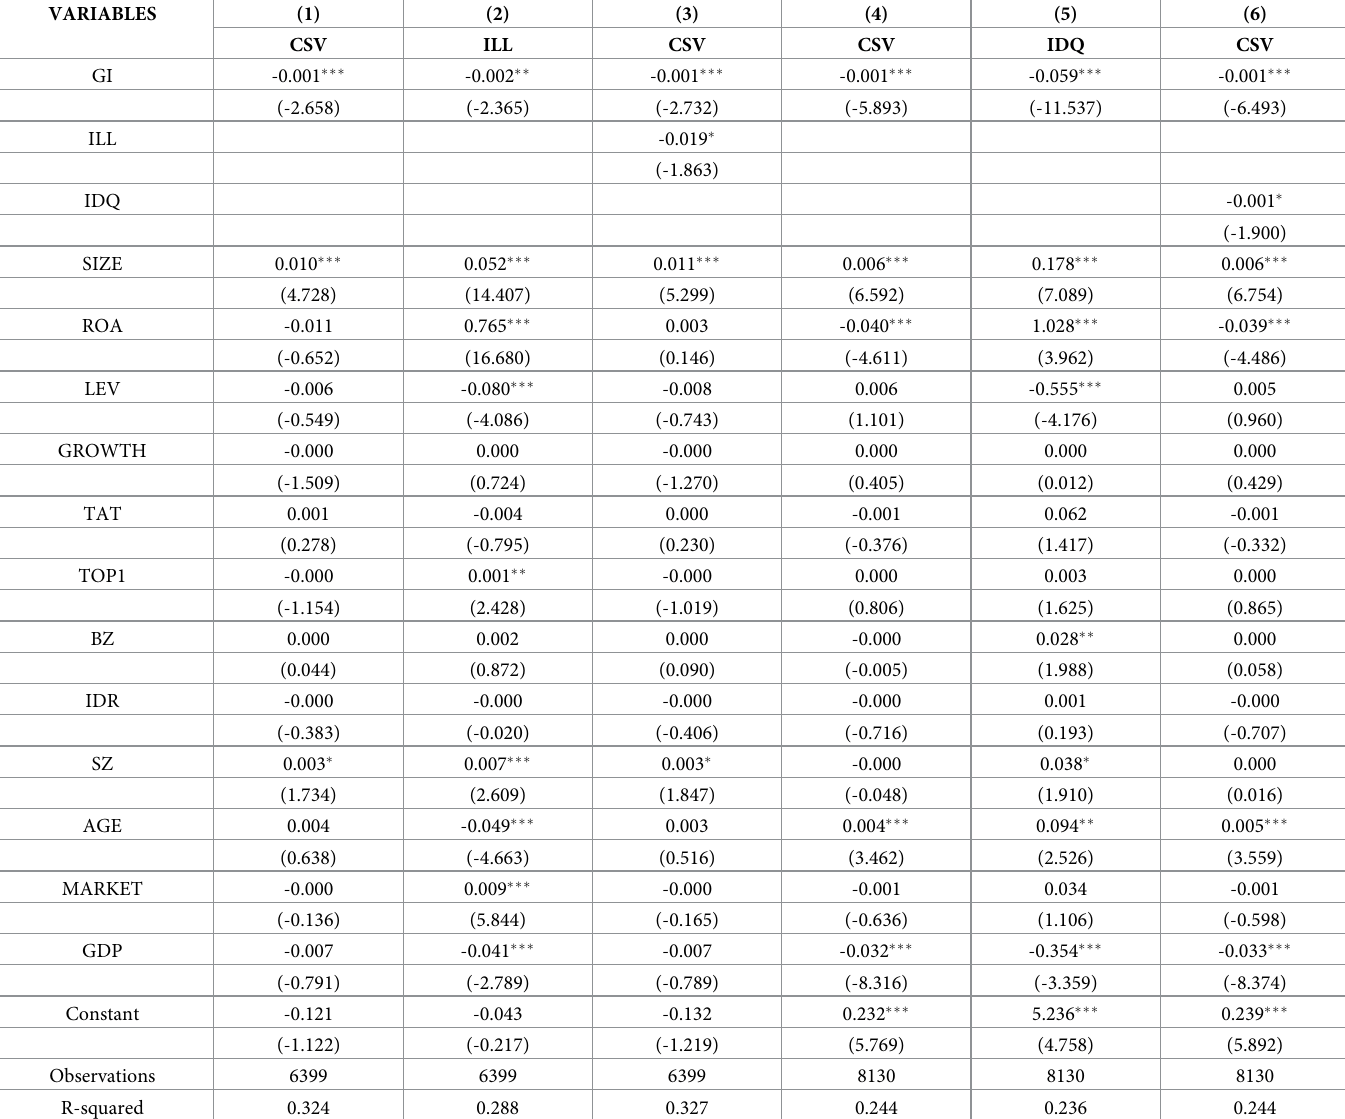
Table 8. Mediation effect test